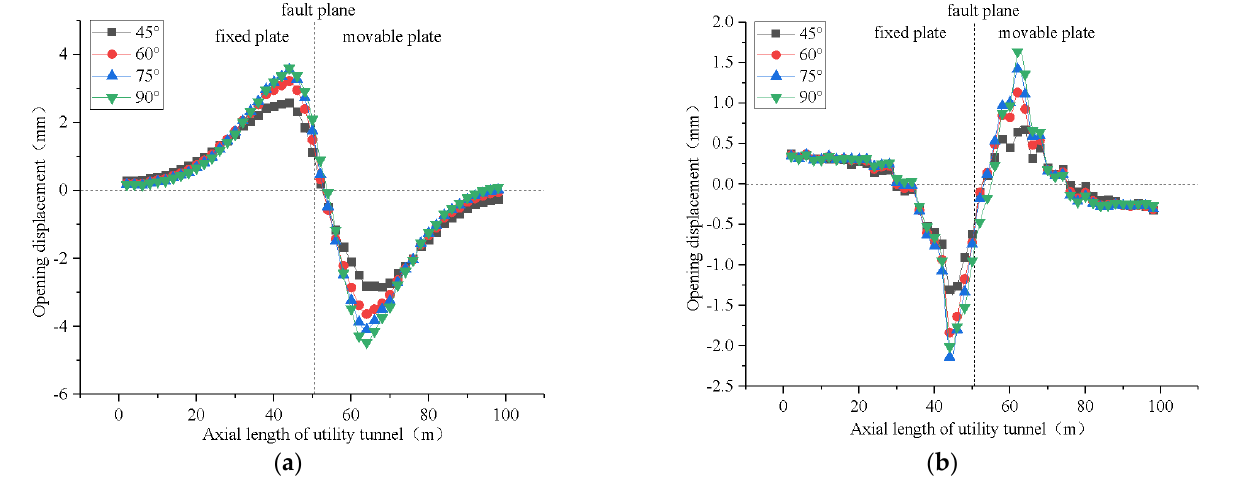
Figure 19. Distribution curve of the longitudinal horizontal opening displacement. ( a ) Roof ( b ) Floor.